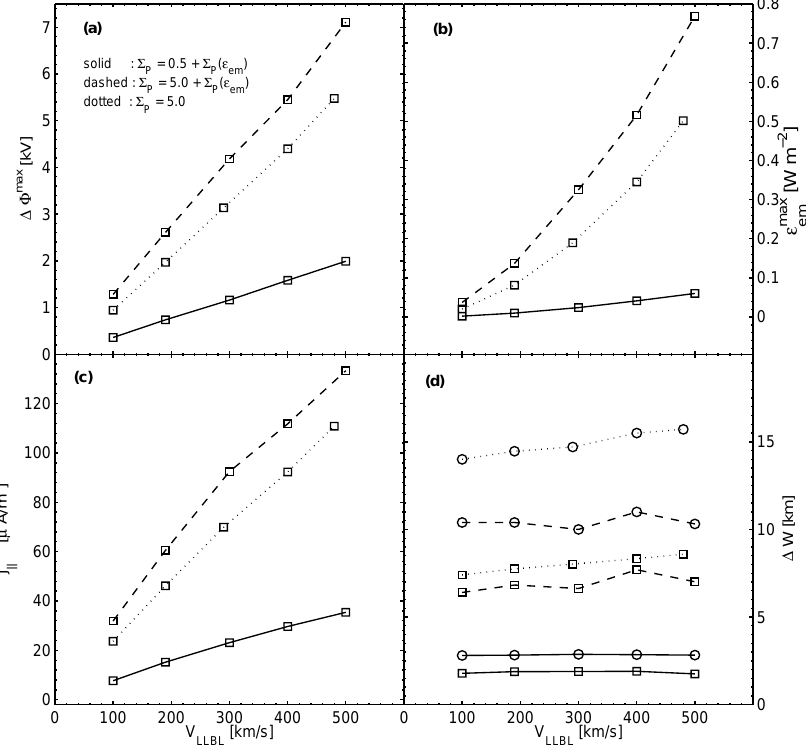
Fig. 6. Auroral arc’s characteristics as a function of the bulk velocity at the LLBL side of the magnetospheric TD generator and height- integrated Pedersen conductivity. Solid lines represents results obtained for a 6 P that depends on (cid:15) em (see Eq. 2) with a background conductance 6 P 0 = 0 . 5; dashed lines show results obtained for a non-uniform conductance with 6 P 0 = 5 . 0S; dotted lines correspond to results obtained for a uniform Pedersen conductance, 6 P = 5S. The panels show: (a) the variation with V LLBL of the maximum of the field- aligned potential drop, 18 max ; (b) the variation with V LLBL of the maximum of the flux of precipitating energy, (cid:15) max em ; (c) the variation with V LLBL of the maximum field-aligned current density, j max || ; (d) the width at half maximum of the current sheet (circles) and of the auroral arc (squares) as a function of V LLBL